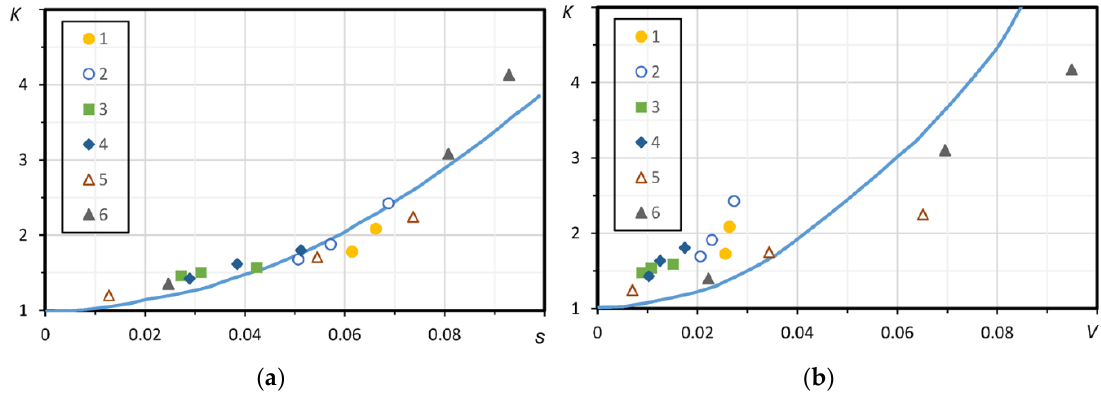
Figure 7. Dependence of relative value K under the log-normal distribution law on mean square deviation s ( a ) and coefficient of variation V ( b ) (1 — σ pr ; 2 — σ 0.2 ; 3 — σ u ; 4 — S k ; 5 — ψ ; and 6 — ψ u ). Table 7. Dependence of the number of specimens on the initial statistical properties.